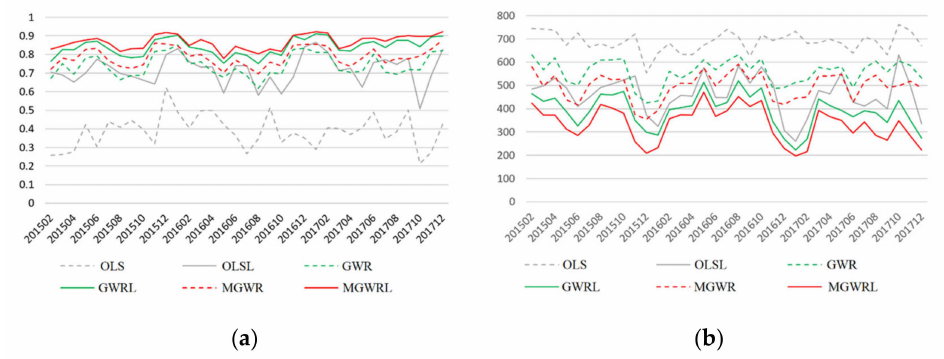
Figure 6. Model comparison of goodness-of-fit: ( a ) R 2 ; ( b ) AICc. A lower AICc indicates a better fitting degree; and two AICc values with a difference of three or more generally indicate a significant difference between model goodness-of-fit